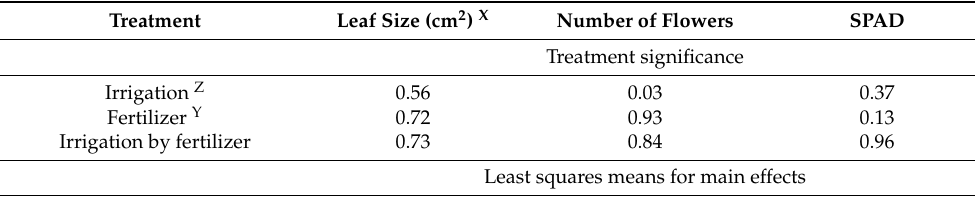
Table 4. Leaf size, number of flowers, and leaf greenness [Special Products Analysis Division (SPAD] of ‘Mellow Yellow’ coneflower at the conclusion of the 61 d experiment. The 40% VWC treatment was considered well-watered while the 18% treatment supplied a reduced irrigation treatment. Leaf size of ten fully expanded leaves was measured at the conclusion of the experiment using a leaf area meter. Treatment Leaf Size (cm 2 ) X Number of Flowers SPAD Treatment significance Irrigation Z